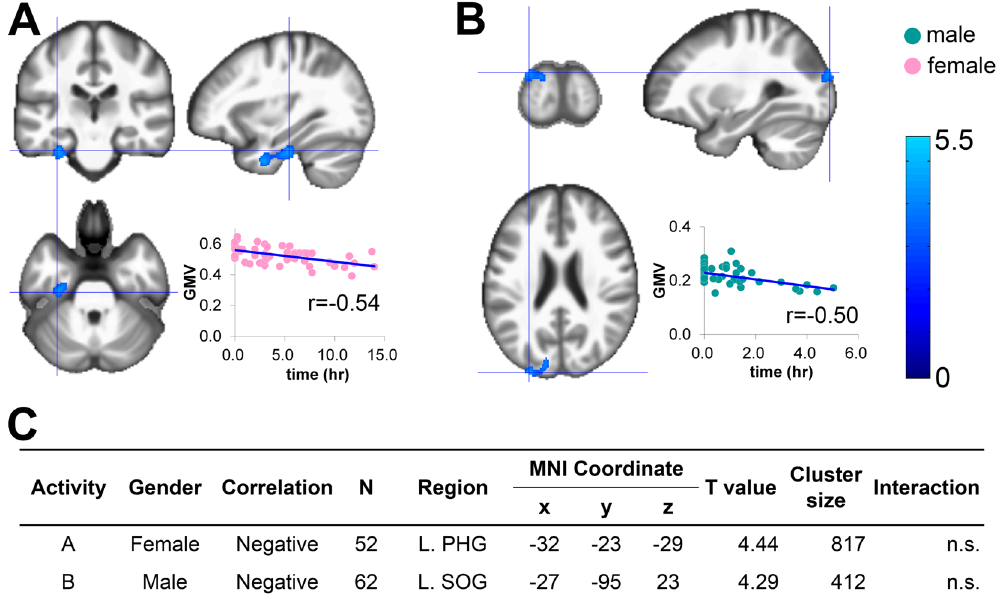
Figure 4. Sex-specific correlations between GMV and each item from the social/interpersonal activities. Regions that survived a statistical threshold of p < 0.05 (cluster-level corrected for multiple comparisons) are shown in ( A ) weekly range of daily time being with Family in females, and ( B ) daily time of being with Other persons in males. ( C ) Summary of the significant correlations. The X-axis of the scatter plot indicates the daily time or weekly range of activities. The Y-axis indicates the extracted GMV over the peak coordinates of the significant cluster. L, left; MNI, Montreal Neurological Institute; PHG, parahippocampal gyrus; SOG, superior occipital gyrus; n.s.: not